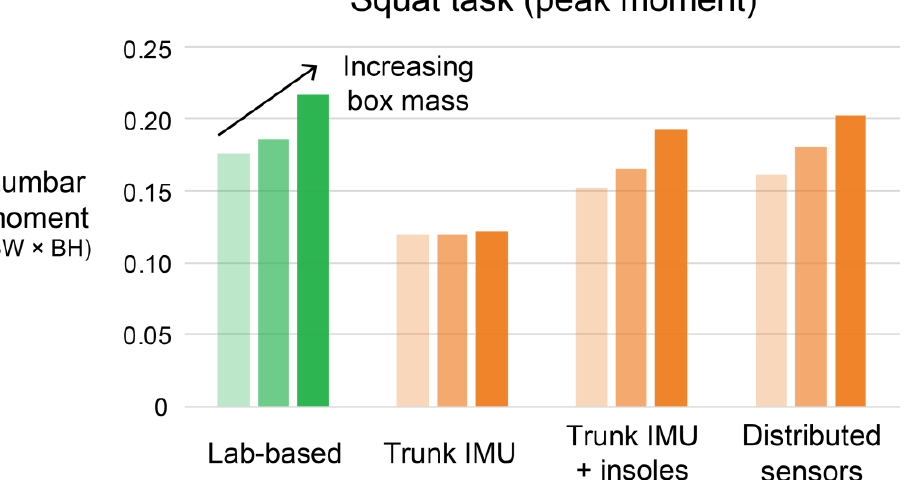
Figure 9. Single IMU wearable does not capture increases in lumbar loading when heavier objects are lifted. Shown is an illustrative example from one participant: peak lumbar moment of squat tasks when increasing box masses are lifted (10 kg, 15 kg, 23 kg are shown). The trunk IMU and insole algorithm, and also the distributed sensor algorithm, captures the trend of increasing lumbar moment with heavier object mass. However, the trunk IMU algorithm does not; it predicts a similar peak moment with each lift regardless of the mass being lifted. BW × BH = body weight × body height.